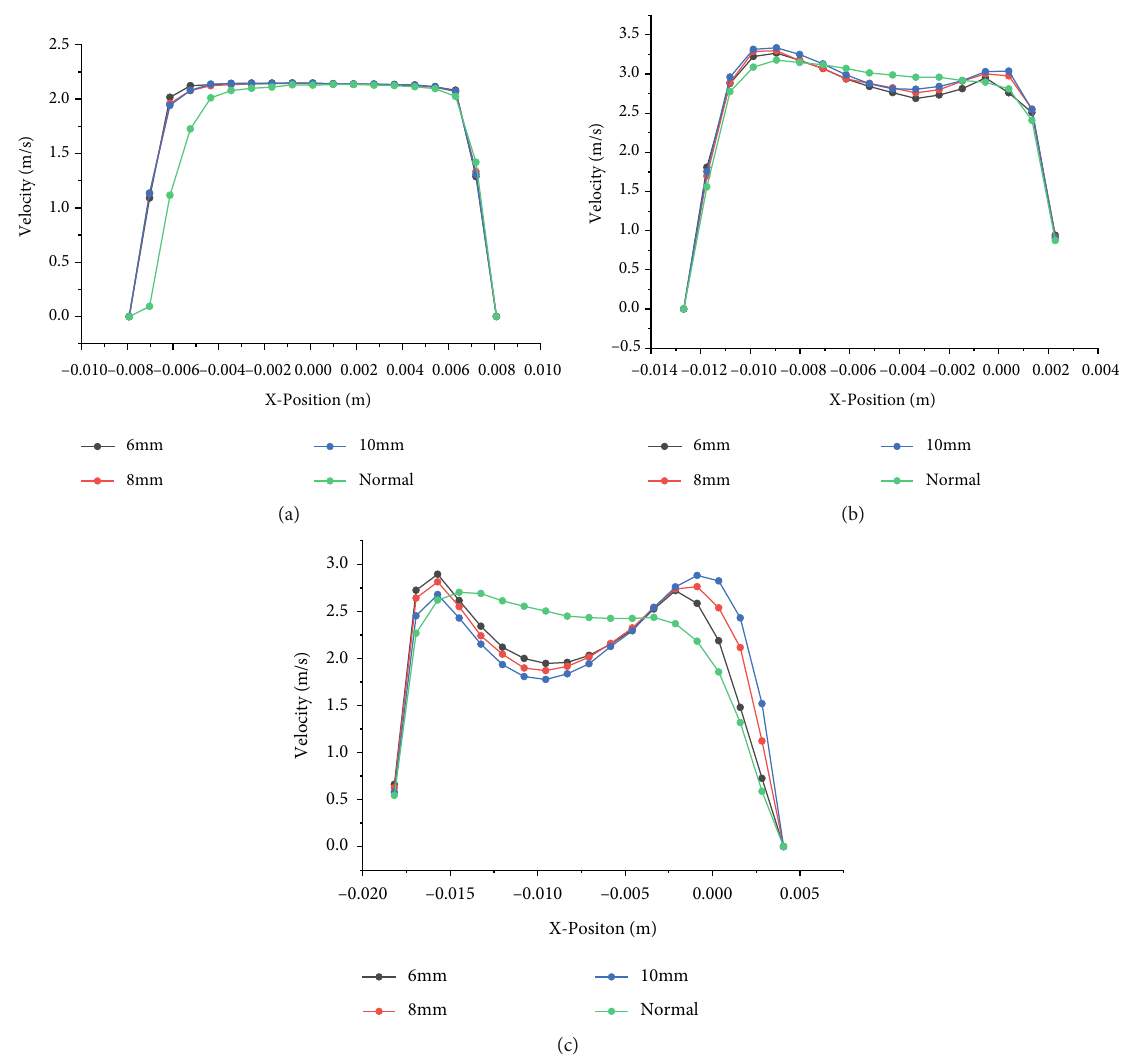
Figure 8: Velocity pro fi les for the healthy airway and three foreign bodies of di ff erent diameters, at (a) line1, (b) line2, (c)